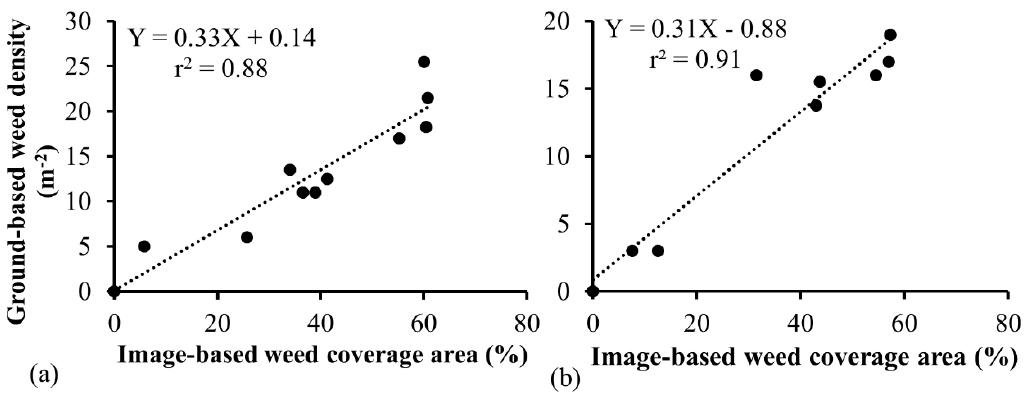
Figure 8. Regression analysis of weed pixel coverage (%) obtained using aerial imagery and ground-based weed density (m − 2 ) for ( a ) red sprangletop and ( b ) Palmer amaranth.